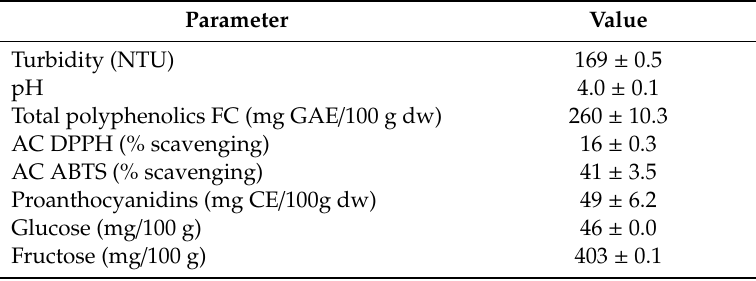
Table 4. Physico-chemical characteristics of red grape pomace